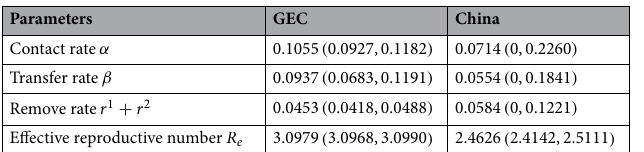
Table 1. The estimated mean and 95% CI of parameters.